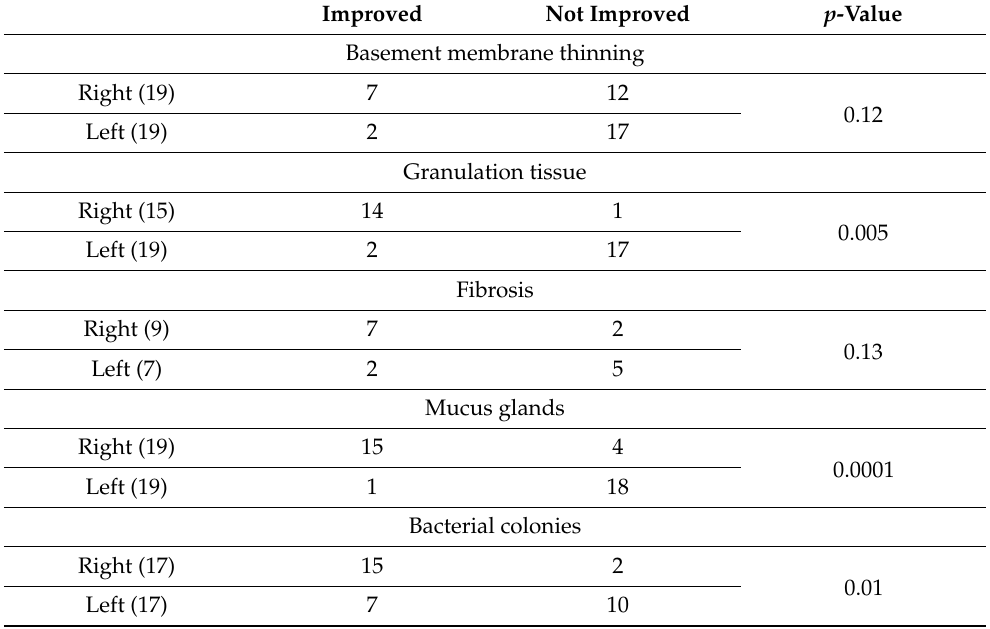
Table 5. Table showing improvement in pathological features in the right (test) and left (control) sides of the nasal cavity pre- and post-intervention, and their statistical significance using Fischer’s exact test.